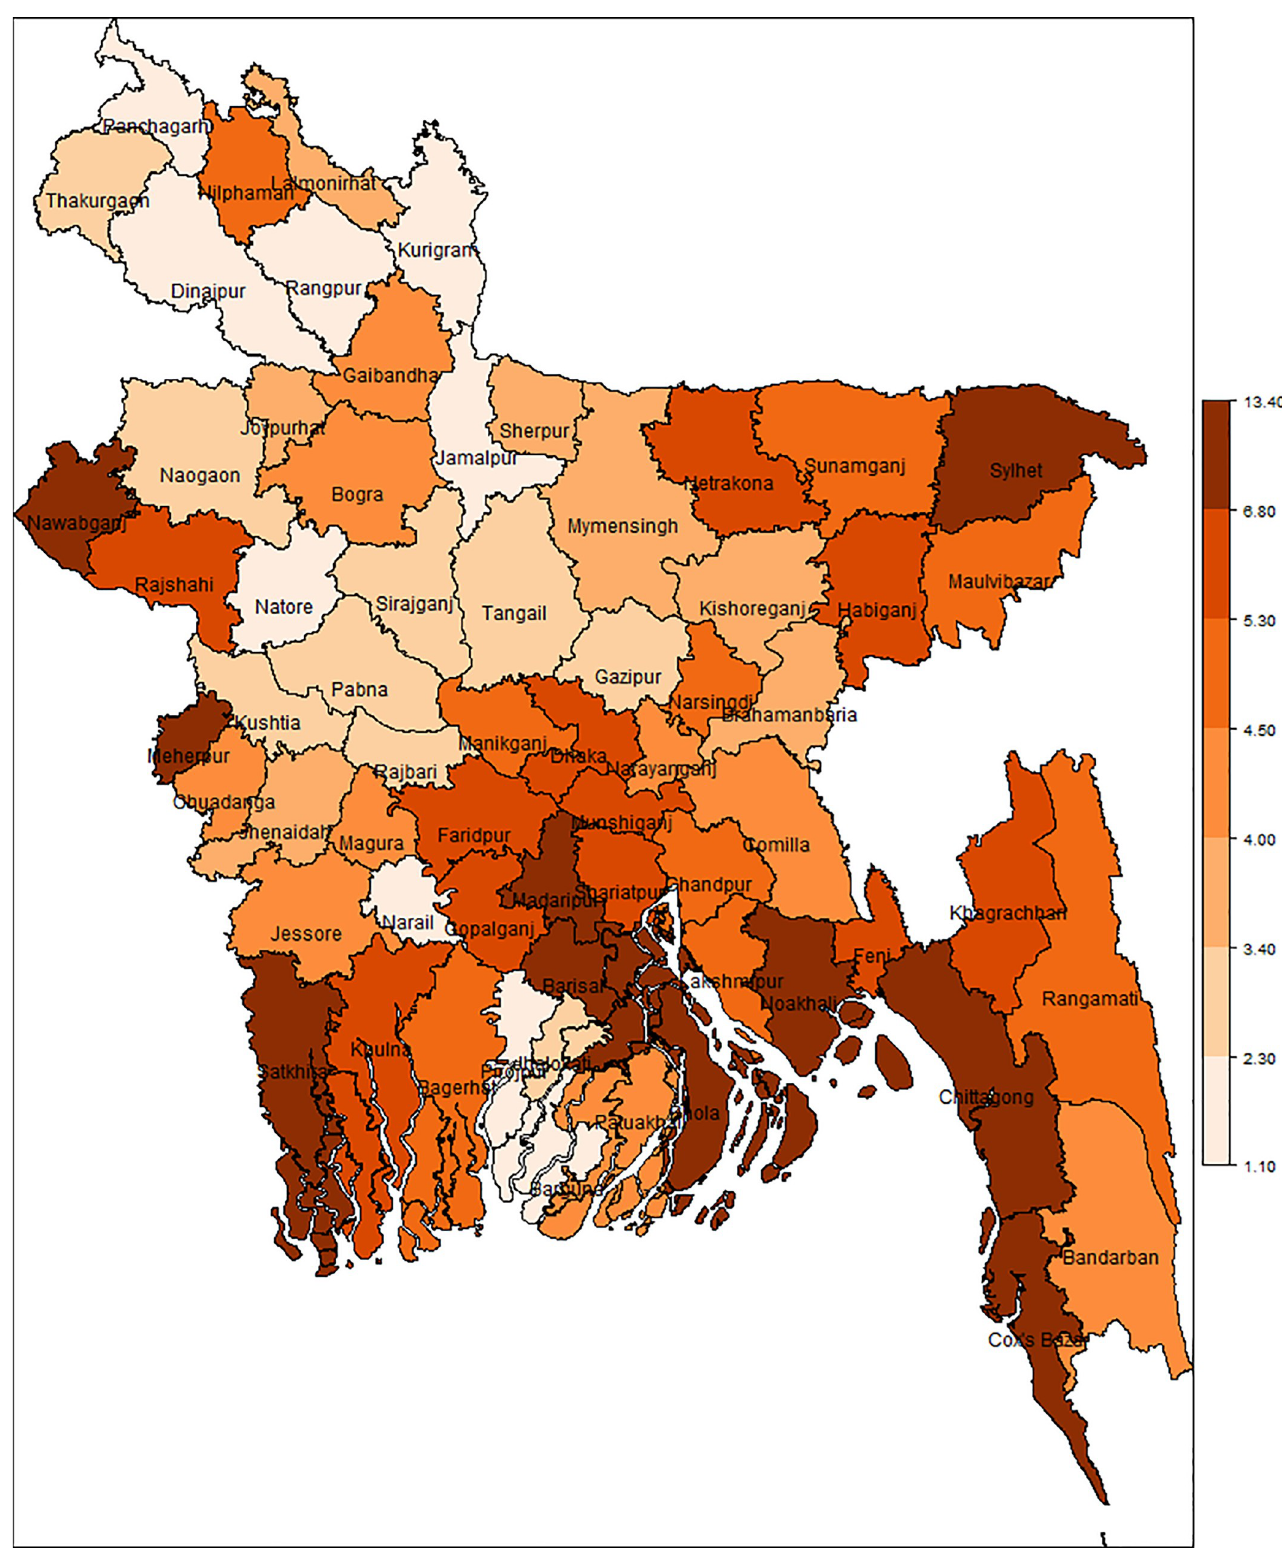
Fig 9. District-wise map showing the spatial distribution of diarrhoea prevalence (%) generated by model-based (EP) method in Bangladesh.